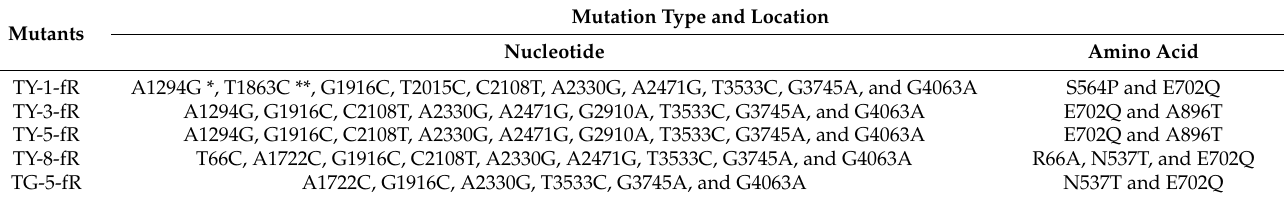
Table 4. Mutations in the predicted FoOs1 protein sequence of five fludioxonil-resistant mutants of FOM.